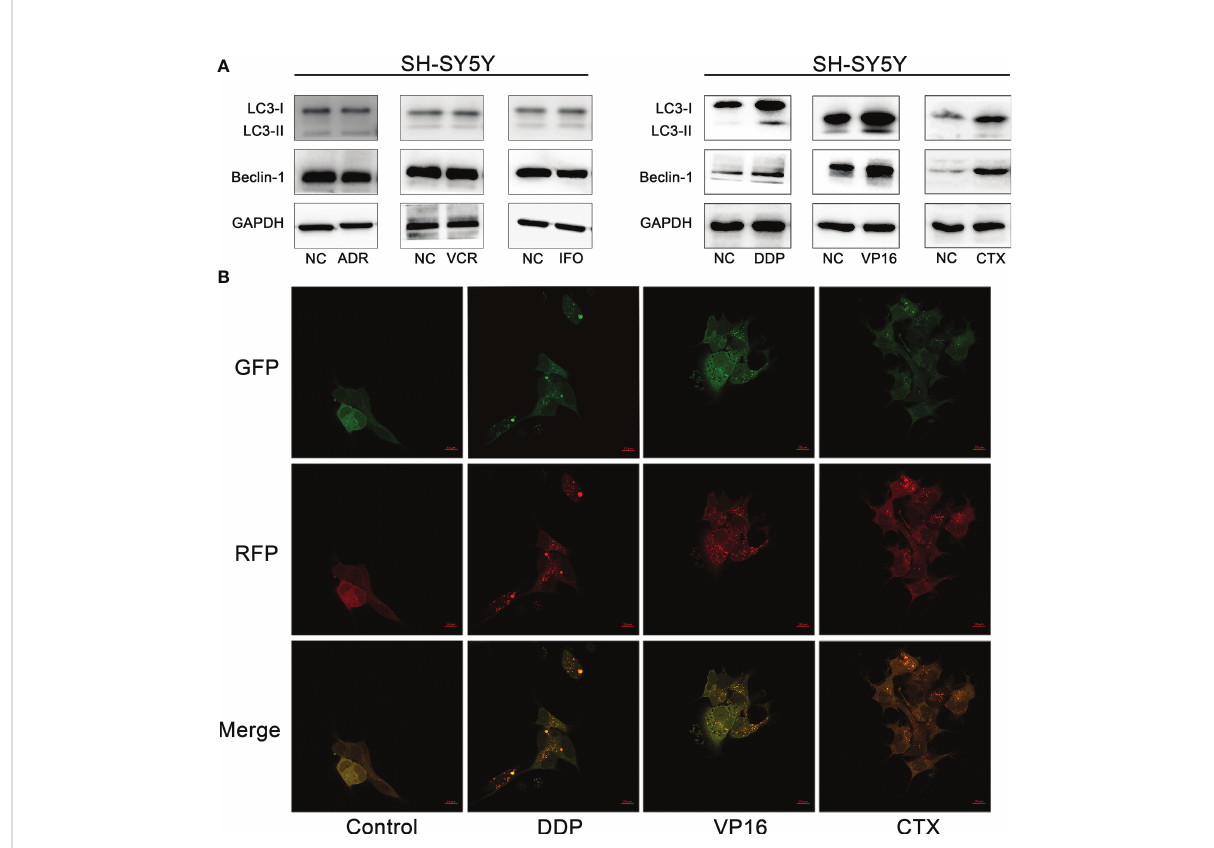
FIGURE 2 Autophagy induced by chemotherapy agents in neuroblastoma cells. (A) Western blot analysis showed that DDP, VP16 and CTX induced increased expression of LC3-I, LC3-II and Beclin-1 after SH-SY5Y cells were treated with 6 chemotherapy agents. However, IFO, VCR and ADR showed no increase in autophagy related protein expression. (B) Confocal microscopy observed that autophagic vesicles increased signi fi cantly after tumor cells were exposed to chemotherapy agents (DDP, CTX, VP16) compared with the untreated